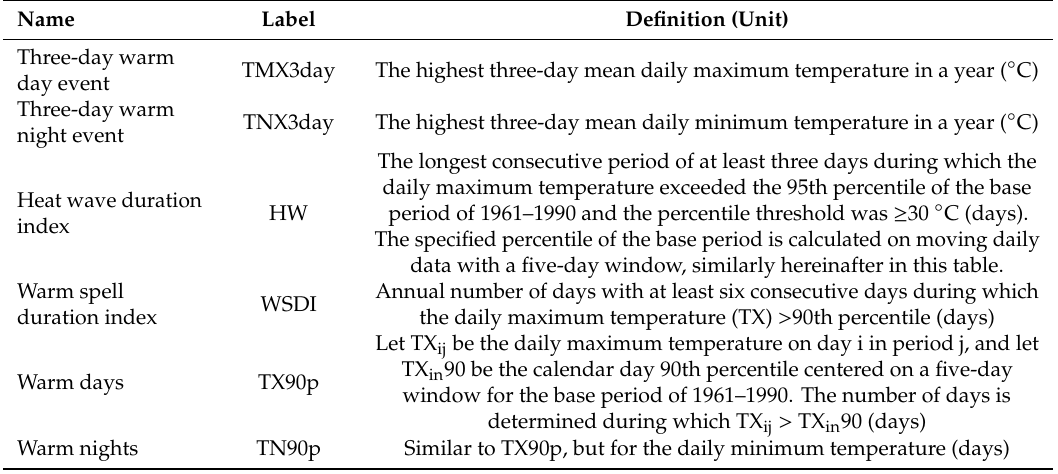
Table 1. Definitions of extreme high-temperature indices used in this study (present climatology of these extreme high-temperature indices refers to Figure